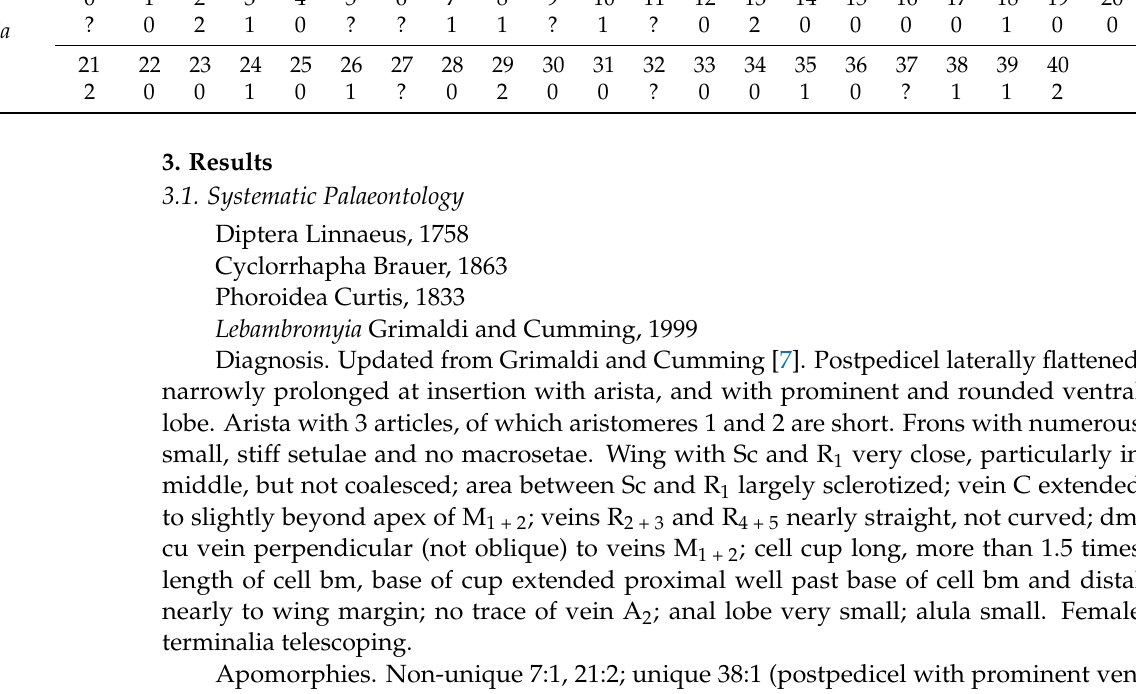
Table 3. Scoring of Lebambromyia sacculifera in the morphological dataset of Li and Yeates [8]. Taxon